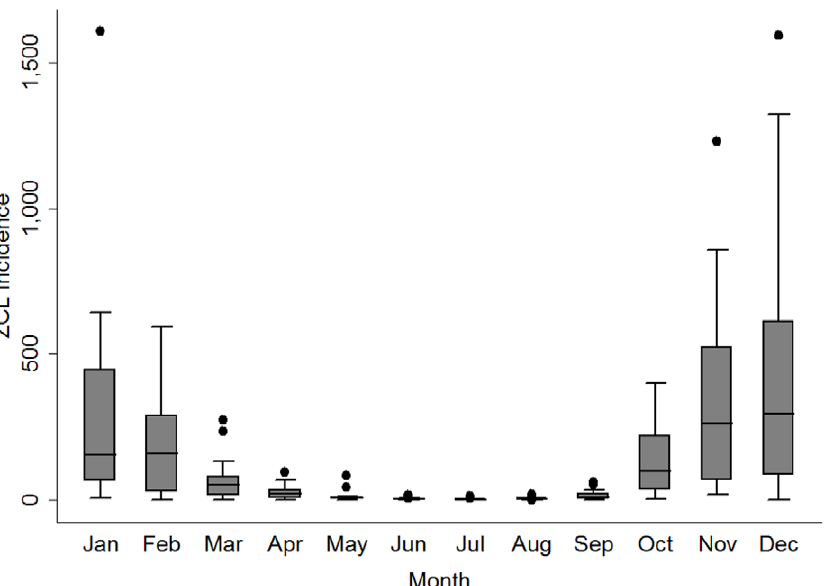
Figure 2. Box plot with monthly ZCL incidence. Data was aggregated from January 1991 to December 2007. The box represents the 25th and 75th percentiles. The median is represented by a solid horizontal line. The whiskers of the graph show the 1st percentile to the 99th percentile. Values lower than the first and greater than the 99th percentile are represented by a point.